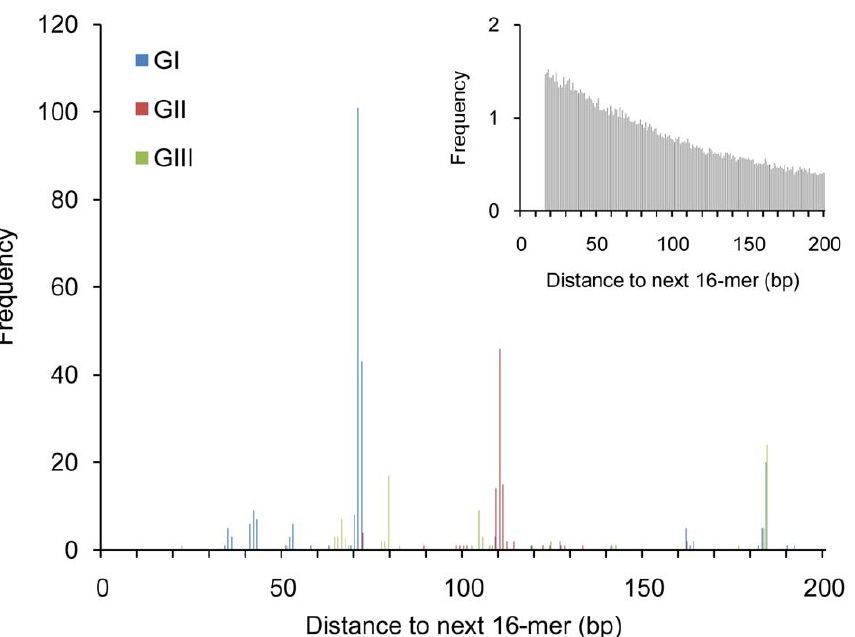
Figure 2. Frequency of next-neighbor distances for GI, GII, and GIII sequences in the genome of P.fluorescens SBW25. Data are next- neighbor distances for 1,053 GI, GII and GIII sequences in extragenic space, compared to a random model (inset). The peaks at 71 and 110 bp correspond to doublets of GI and GII sequences, respectively. The peak at 184 bp corresponds to GI–GIII tandem repeat clusters (see text). No significant deviation from the random model was noted for next-neighbor distances above 200 bp. The next-neighbor distances of 16-mers randomly assigned to extragenic space is the average of 10,000 simulations (inset).